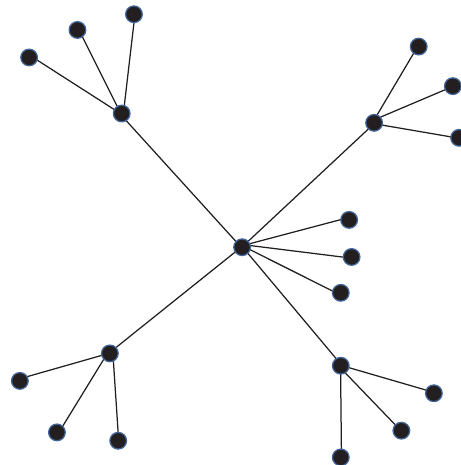
Figure 9: The variance of 𝜆 2 for 𝐾 3,3 ∘ 𝑃 𝑘 .